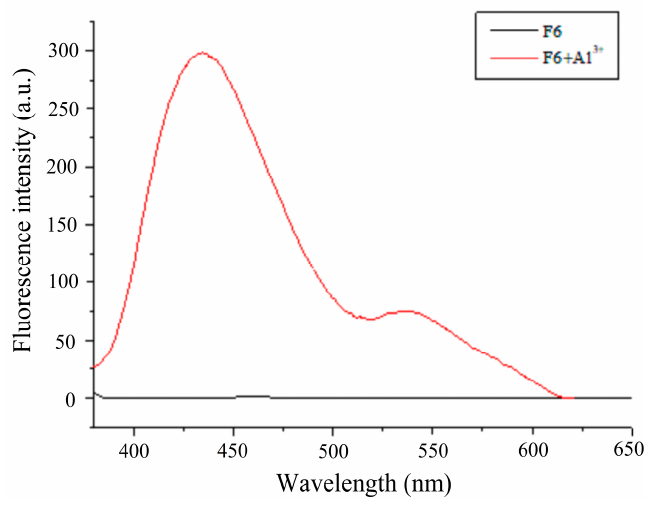
Figure 3. Fluorescence spectrum of F6 and Al 3+ fluorescence systems.